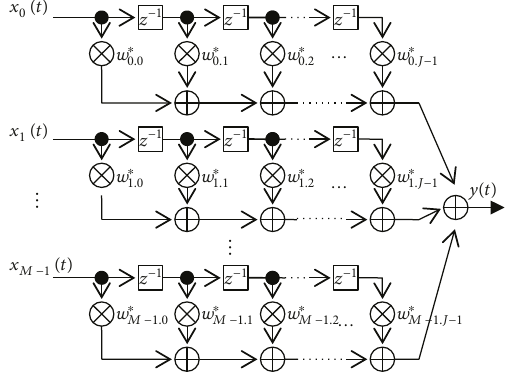
Figure 1: The structure of the space-time